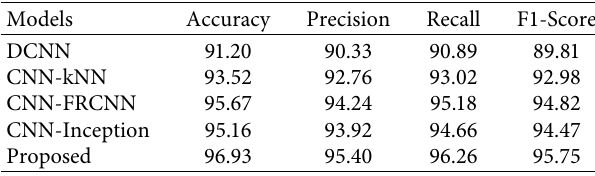
Table 4: Comparison analysis of performances.